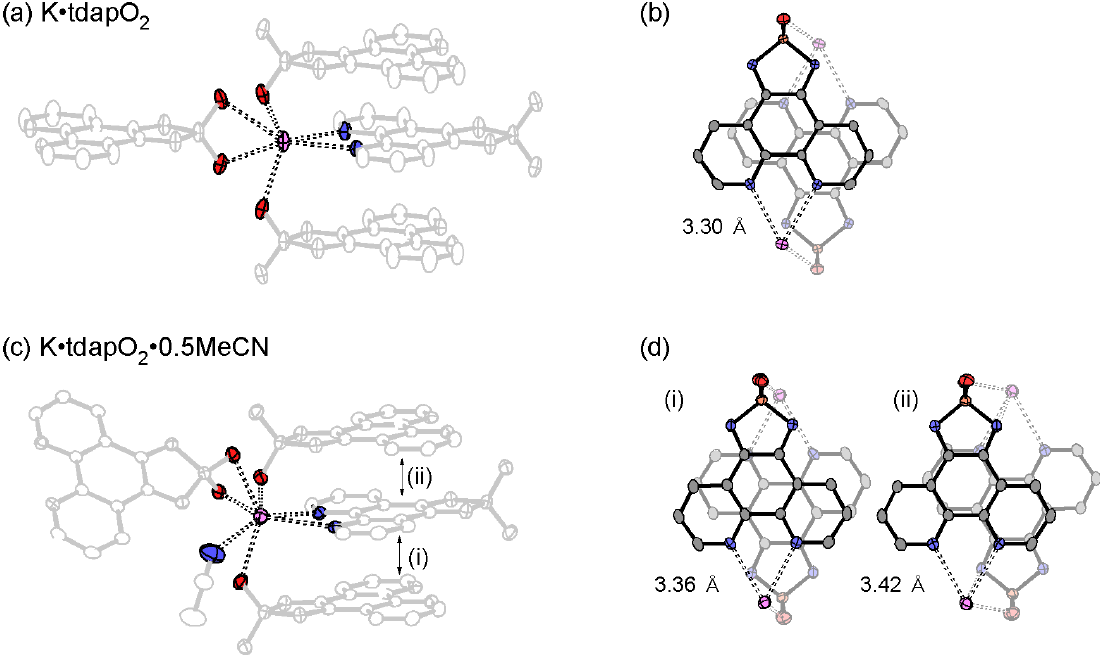
Figure 18. Coordination geometry around the potassium ion ( a , c ) and π -overlaps ( b , d ) in (top) and K•tdapO •0.5MeCN (bottom). Adapted with permission from K•tdapO 2 2